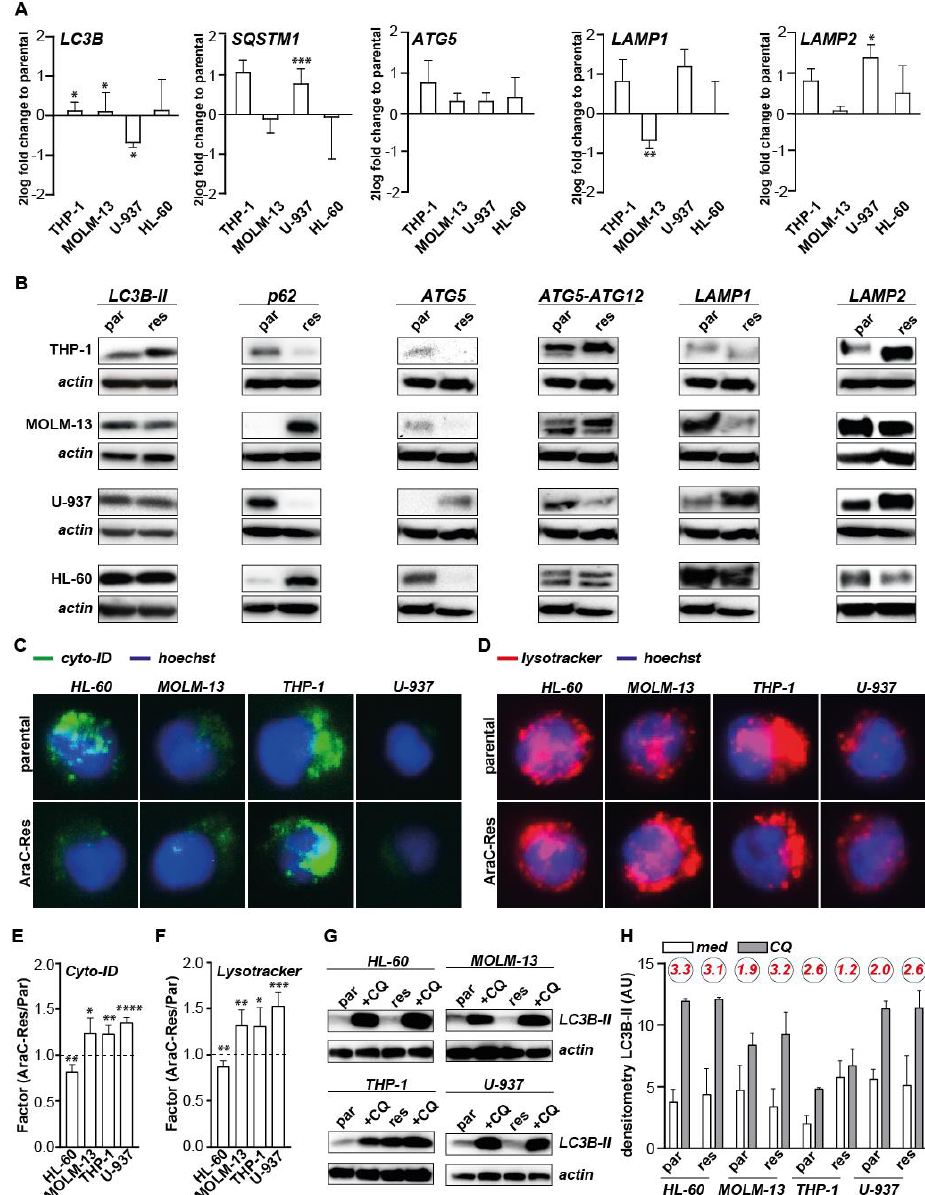
Figure 2. Expression of general autophagy genes and proteins is not elevated in AraC resistant AML cells. ( A ) mRNA expression levels of autophagy genes measured in all cell line pairs and presented as a log fold change of the AraC-Res cell line compared to the parental cell line ( n = 3). ( B ) Representative protein expression levels of autophagy-related proteins (LC3B-II (14 kDa), p62 (62 kDa), ATG5 (32 kDa), ATG5-ATG12 (55 kDa), LAMP1 (130 kDa), LAMP2 (130 kDa), and loading control beta-actin (42 kDa) in parental and AraC-Res cell lines as determined by Western blot ( n = 3). ( C ) Representative fluorescent pictures of parental and AraC-Res cell lines stained for basal autophagosomal content using Cyto-ID, captured at 40× magnification. ( D ) As in ( C ) but stained for basal lysosomal content using lysotracker. ( E , F ) The difference in basal cyto-ID and lysotracker signal between AraC-Res and parental cell lines (depicted as a factor, AraC-Res/parental) as measured using flow cytometry ( n = 4). ( G ) Representative Western blots showing the basal autophagic flux in parental versus AraC-Res cell lines using chloroquine (CQ, 50 μM for 6 h) ( n = 2). ( H ) Densitometry measurements of the experiment as shown in ( G ), showing the factor increase in LC3B-II in CQ treated versus untreated cells in red ( n = 2). Significance was tested using a student’s t-test. p values are indicated as: **** p < 0.0001, *** p < 0.001, ** p < 0.01, and * p < 0.05.